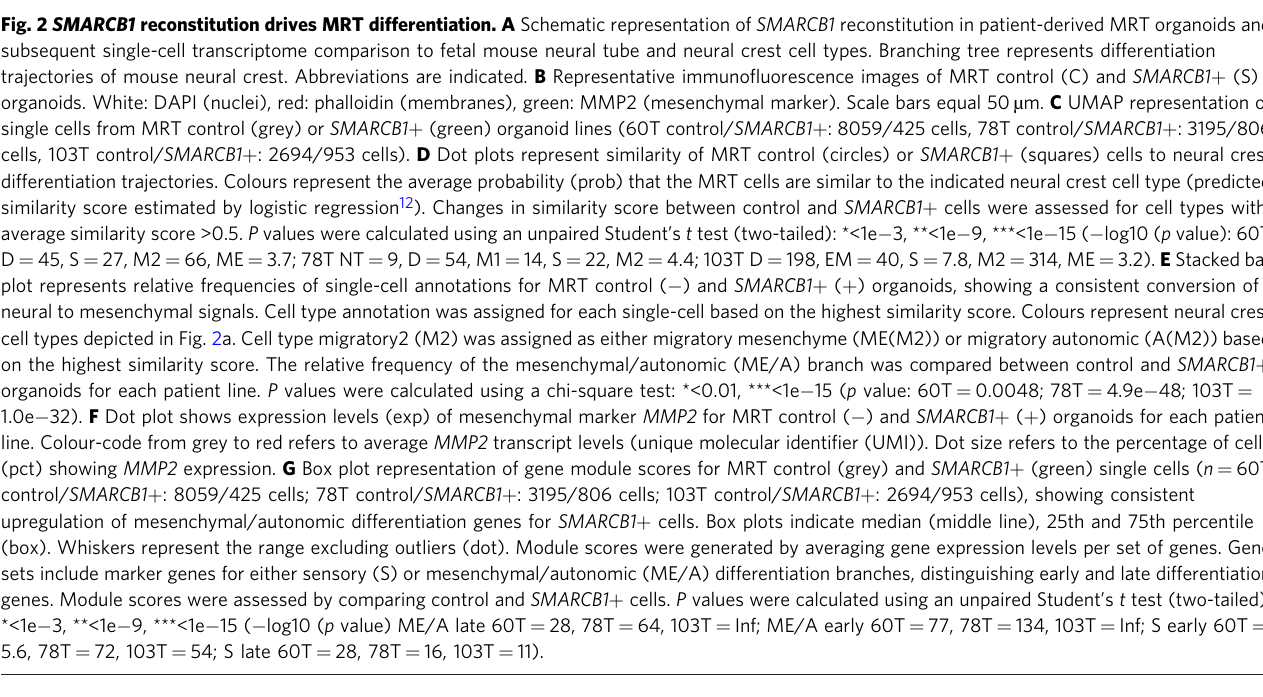
Fig. 2 SMARCB1 reconstitution drives MRT differentiation. A Schematic representation of SMARCB1 reconstitution in patient-derived MRT organoids and subsequent single-cell transcriptome comparison to fetal mouse neural tube and neural crest cell types. Branching tree represents differentiation trajectories of mouse neural crest. Abbreviations are indicated. B Representative immuno fl uorescence images of MRT control (C) and SMARCB1 + (S) organoids. White: DAPI (nuclei), red: phalloidin (membranes), green: MMP2 (mesenchymal marker). Scale bars equal 50 µ m. C UMAP representation of single cells from MRT control (grey) or SMARCB1 + (green) organoid lines (60T control/ SMARCB1 + : 8059/425 cells, 78T control/ SMARCB1 + : 3195/806 cells, 103T control/ SMARCB1 + : 2694/953 cells). D Dot plots represent similarity of MRT control (circles) or SMARCB1 + (squares) cells to neural crest differentiation trajectories. Colours represent the average probability (prob) that the MRT cells are similar to the indicated neural crest cell type (predicted similarity score estimated by logistic regression 12 ). Changes in similarity score between control and SMARCB1 + cells were assessed for cell types with average similarity score >0.5. P values were calculated using an unpaired Student ’ s t test (two-tailed): *<1e − 3, **<1e − 9, ***<1e − 15 ( − log10 ( p value): 60T D = 45, S = 27, M2 = 66, ME = 3.7; 78T NT = 9, D = 54, M1 = 14, S = 22, M2 = 4.4; 103T D = 198, EM = 40, S = 7.8, M2 = 314, ME = 3.2). E Stacked bar plot represents relative frequencies of single-cell annotations for MRT control ( − ) and SMARCB1 + ( + ) organoids, showing a consistent conversion of neural to mesenchymal signals. Cell type annotation was assigned for each single-cell based on the highest similarity score. Colours represent neural crest cell types depicted in Fig. 2a. Cell type migratory2 (M2) was assigned as either migratory mesenchyme (ME(M2)) or migratory autonomic (A(M2)) based on the highest similarity score. The relative frequency of the mesenchymal/autonomic (ME/A) branch was compared between control and SMARCB1 + organoids for each patient line. P values were calculated using a chi-square test: *<0.01, ***<1e − 15 ( p value: 60T = 0.0048; 78T = 4.9e − 48; 103T = 1.0e − 32). F Dot plot shows expression levels (exp) of mesenchymal marker MMP2 for MRT control ( − ) and SMARCB1 + ( + ) organoids for each patient line. Colour-code from grey to red refers to average MMP2 transcript levels (unique molecular identi fi er (UMI)). Dot size refers to the percentage of cells (pct) showing MMP2 expression. G Box plot representation of gene module scores for MRT control (grey) and SMARCB1 + (green) single cells ( n = 60T control/ SMARCB1 + : 8059/425 cells; 78T control/ SMARCB1 + : 3195/806 cells; 103T control/ SMARCB1 + : 2694/953 cells), showing consistent upregulation of mesenchymal/autonomic differentiation genes for SMARCB1 + cells. Box plots indicate median (middle line), 25th and 75th percentile (box). Whiskers represent the range excluding outliers (dot). Module scores were generated by averaging gene expression levels per set of genes. Gene sets include marker genes for either sensory (S) or mesenchymal/autonomic (ME/A) differentiation branches, distinguishing early and late differentiation genes. Module scores were assessed by comparing control and SMARCB1 + cells. P values were calculated using an unpaired Student ’ s t test